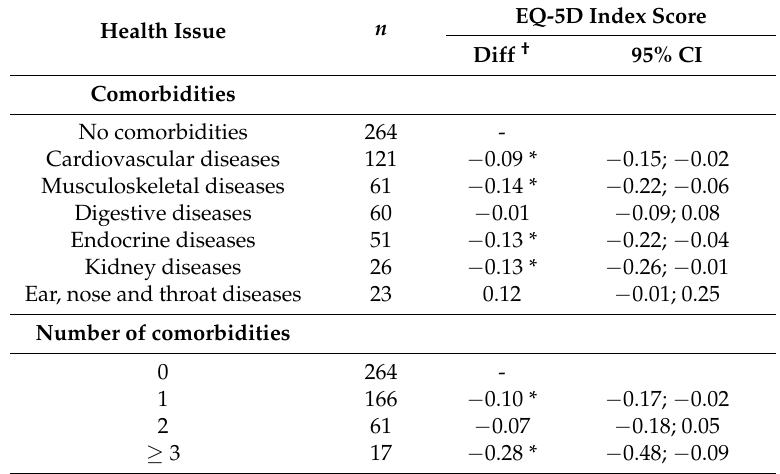
Table 3. Between-group minimal clinically important difference (MCID) of EQ-5D index scores for different